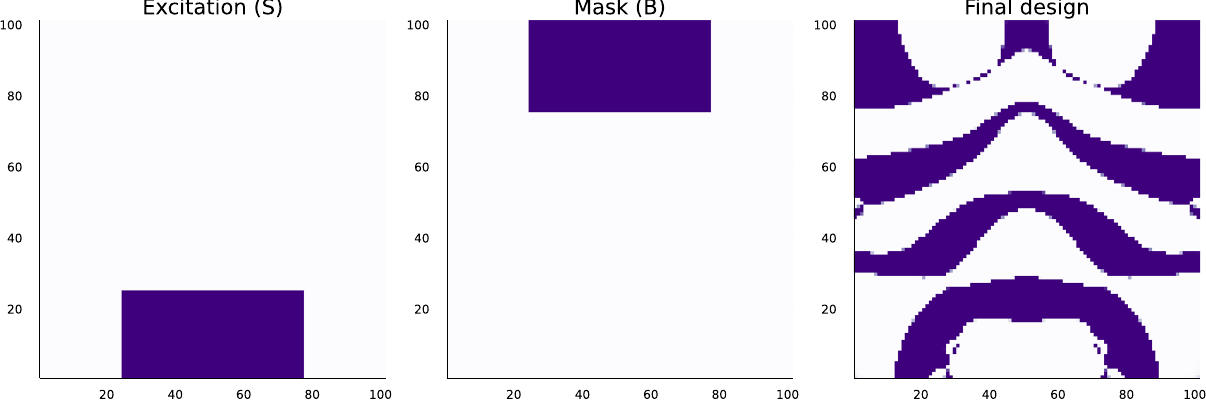
Figure 1. Approximately optimal photonic design. The leftmost figure specifies S ⊆ { 1, . . . , n } in purple, the center specifies B ⊆ { 1, . . . , n } , while the rightmost figure gives the design, θ